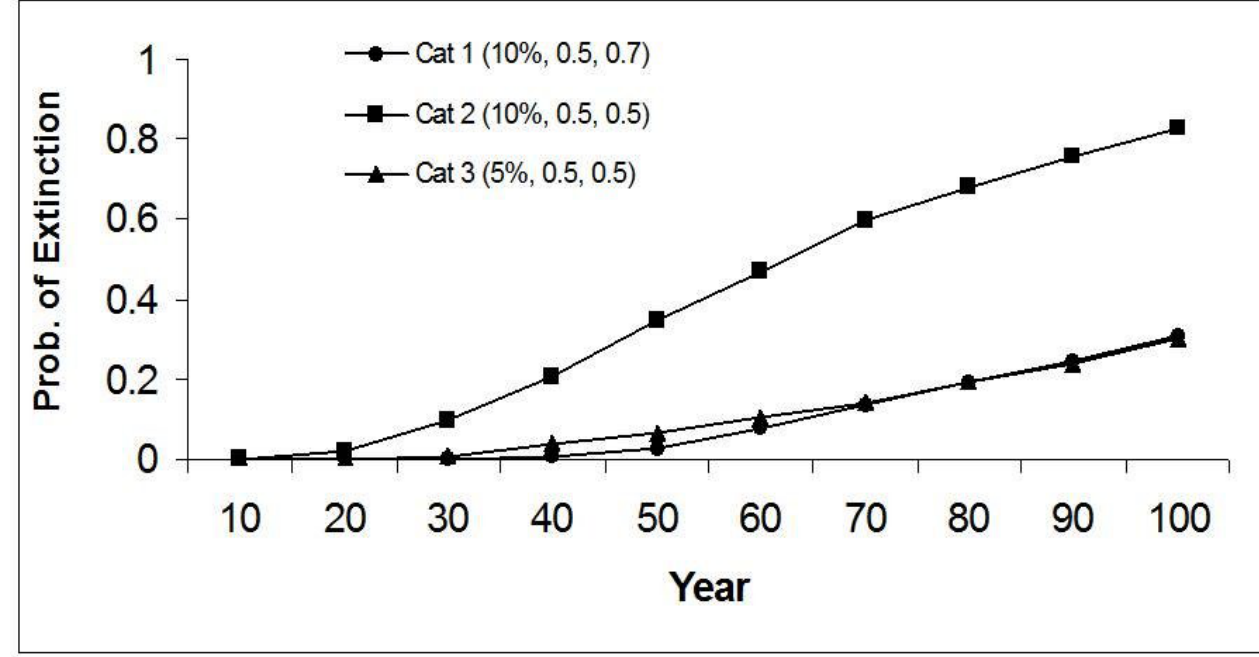
Fig. 5. Probability of extinction of the greater glider within the Karawatha and Kuraby metapopulation under different catastrophe scenarios. Catastrophes have three attributes: a frequency (annual probability of 5%–10%), and an influence on the proportion of females breeding (0.5), and proportion of individuals surviving (0.5–0.7). We modeled three types of catastrophes (cat. 1–3), which comprise different values of these